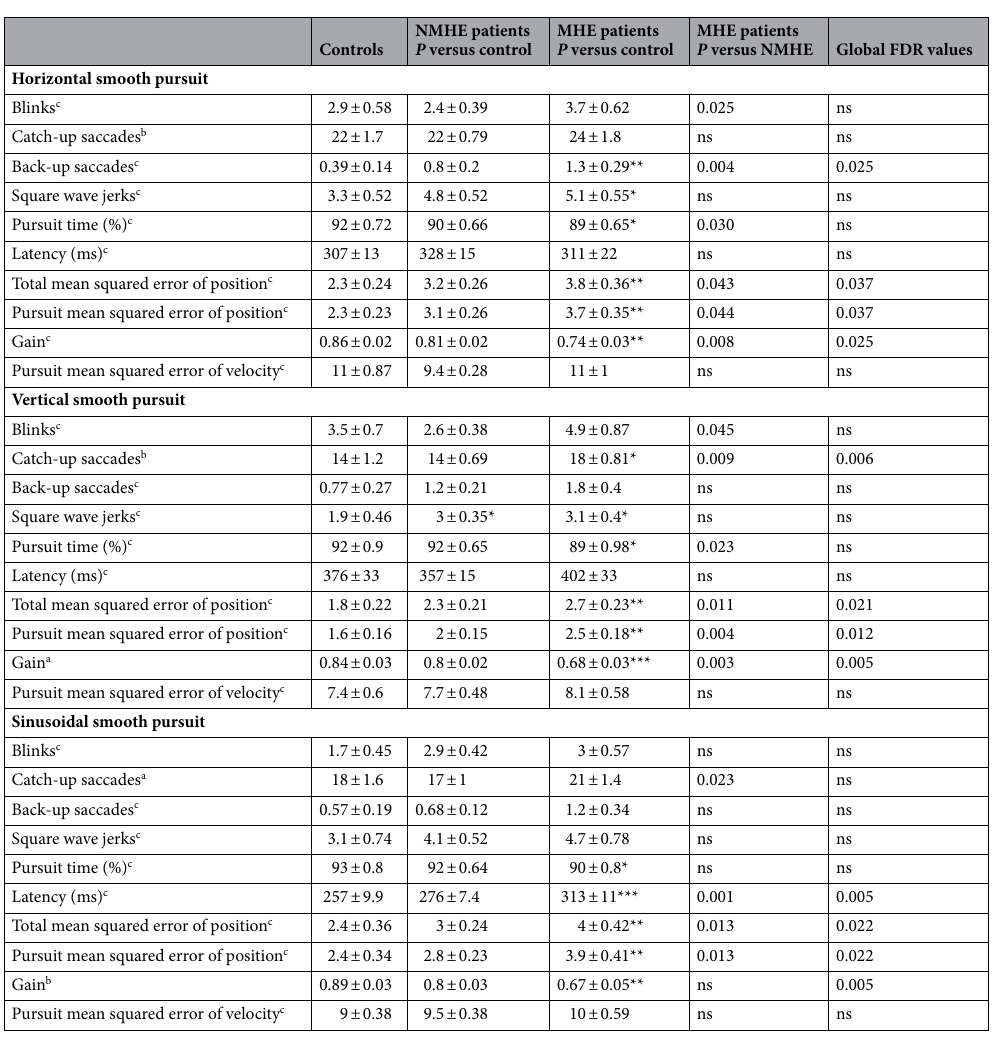
and with minimal hepatic encephalopathy according to PHES. Differences between groups were analyzed using one of three possibilities: one-way ANOVA followed by Tukey’s multiple comparison test (a) parametric and homoscedastic variables, Welch’s ANOVA followed by Games-Howell’s multiple comparison test (b) for parametric but non-homoscedastic variables, and Kruskal–Wallis followed by Dunn’s multiple comparison test (c) for non-parametric variables. Significant differences compared to controls are indicated by asterisks: * p < 0.05; ** p < 0.01; *** p < 0.001; ns, non-significant. Detailed definitions of eye movement variables are in Supporting